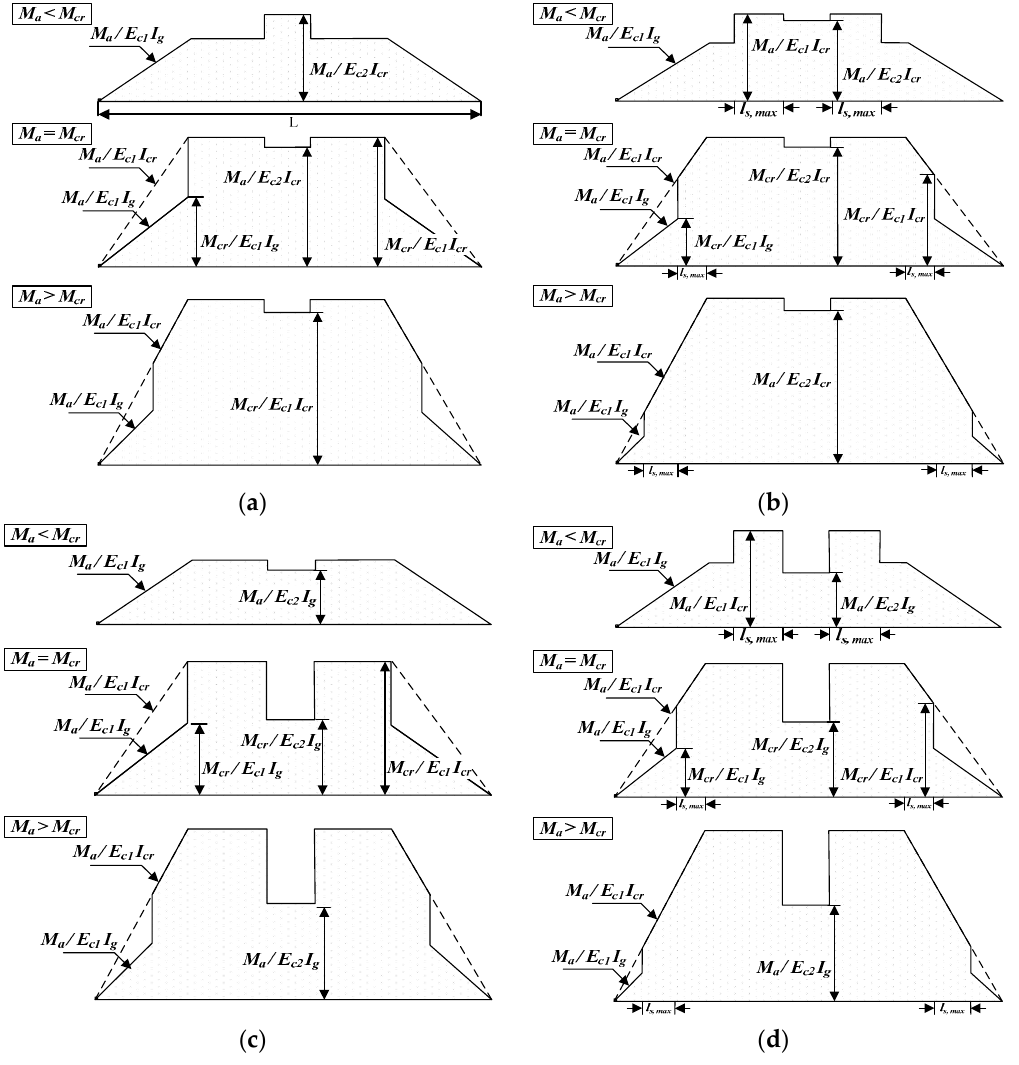
Figure 8. Proposed curvature diagrams for the modular specimen: ( a ) Case 1; ( b ) Case 2; ( c ) Case 3; ( d ) Case 4.